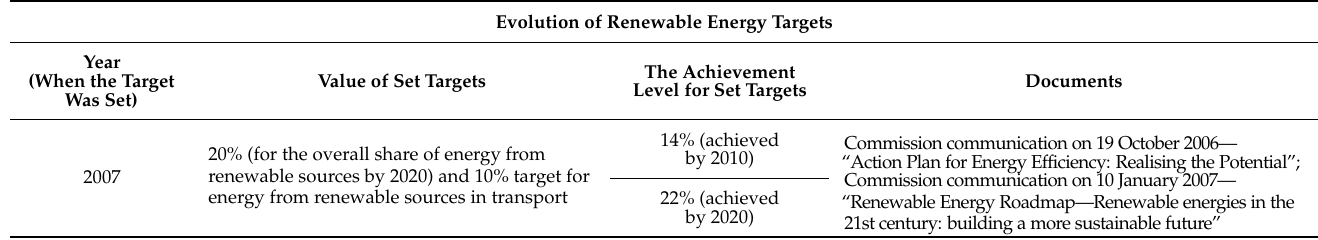
Table 7. Evolution of renewable energy targets for EU member states,